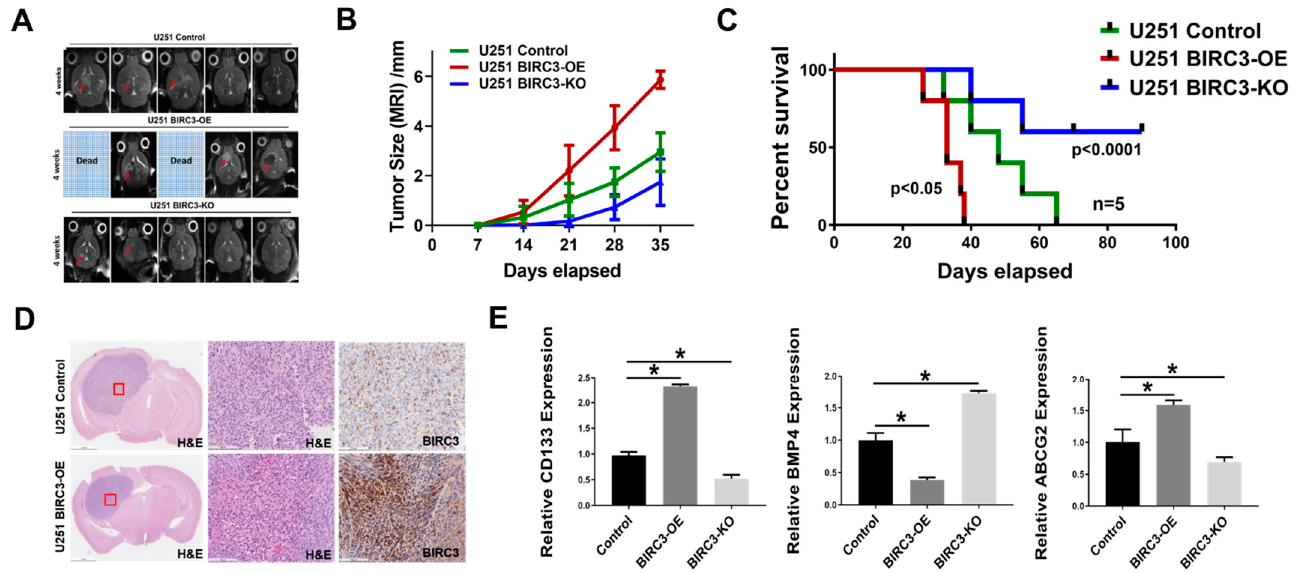
Figure 5. BIRC3 influences tumor initiation and progression in GBM orthotopic xenograft model. GBM Intracranial models with control, BIRC3-OE and BIRC3-KO U251 cells. ( A ). Horizontal axial MRI scan of mouse brain tumors 4 weeks after implantation. Two of BIRC3-OE mice were already dead at 4 weeks. ( B ). Tumor size calculation from MRI scan. n = 5. ( C ). Kaplan-Meier survival curve of U251 control BIRC3-OE and BIRC3-KO intracranial injection mice. n = 5 mice/group. ( D ). Mice were sacrificed at different timepoints and brain tissues of U251 control and BIRC3-OE groups were fixed in 10% neutral formalin. H&E staining and BIRC3 immunohistochemistry was performed as described in the Material and Methods Section 4. Five mice were included in this histological study and similar results were observed in each animal. ( E ). When mice were sacrificed, part of tumor tissues were isolated. mRNA from tumor tissues were extracted. BMP4, CD133 and ABCG2 mRNA expression analyzed by real-time PCR in extracted tumor tissues. n = 3, * p < 0.05.